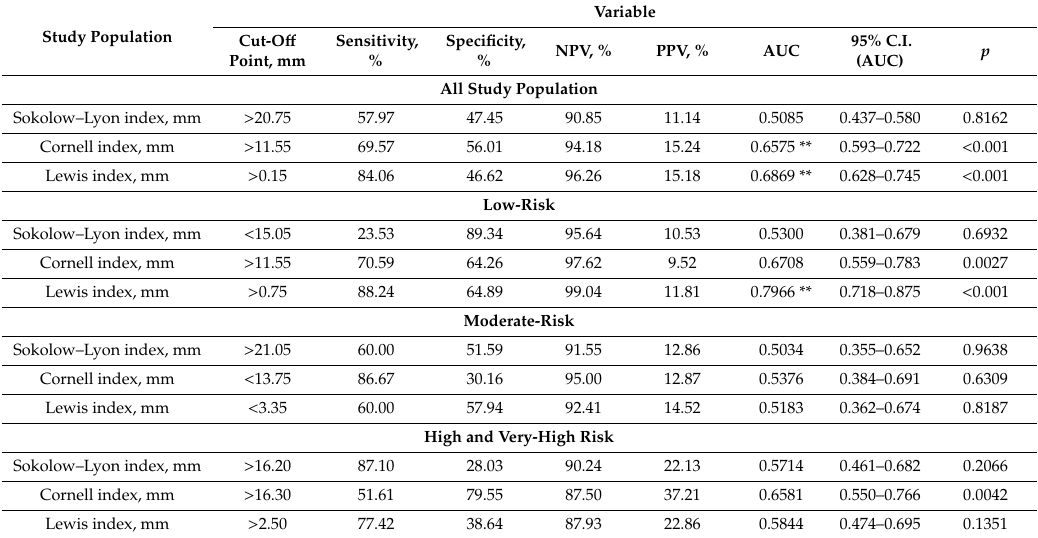
Table 6. Diagnostic accuracy of electrocardiographic criteria to detect the left ventricular hypertrophy * in study population and according cardiovascular risk classes.